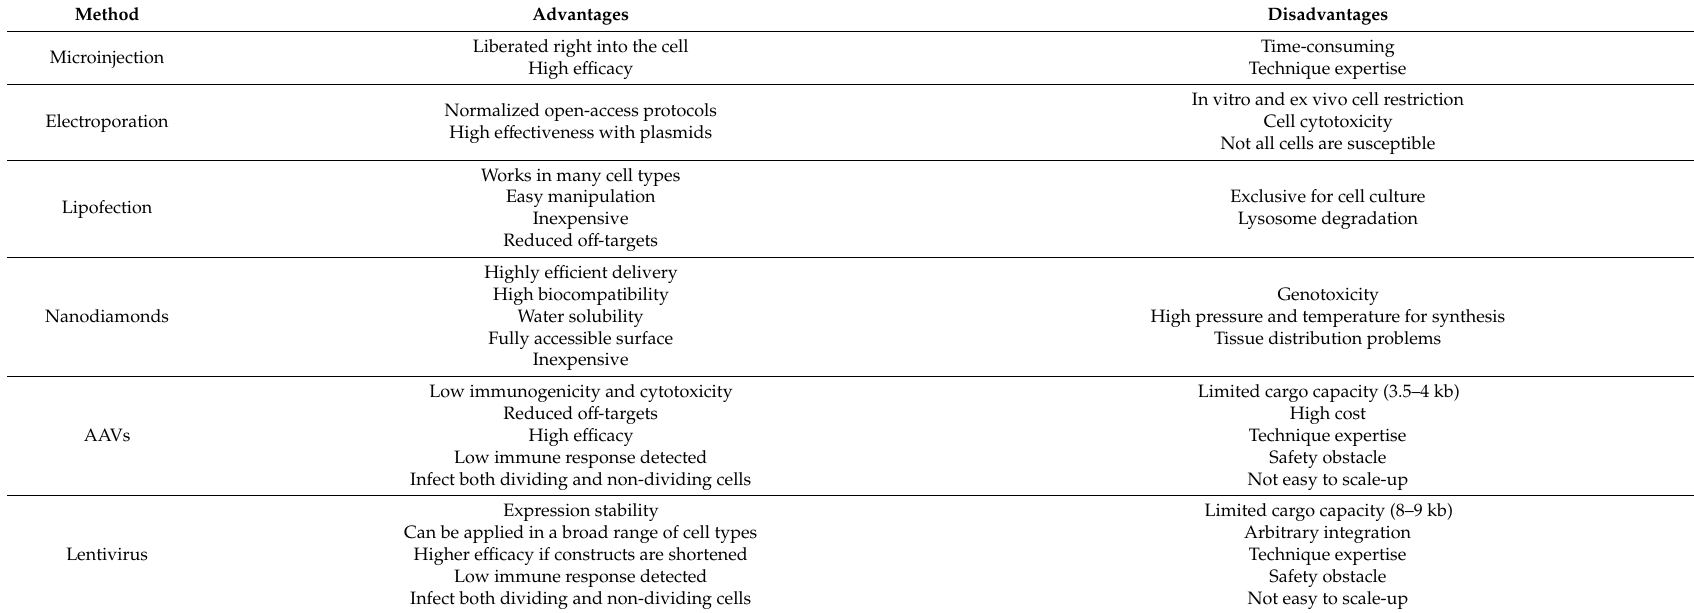
Table 2. Pros and cons of the CRISPR / Cas9 delivery methods described in this